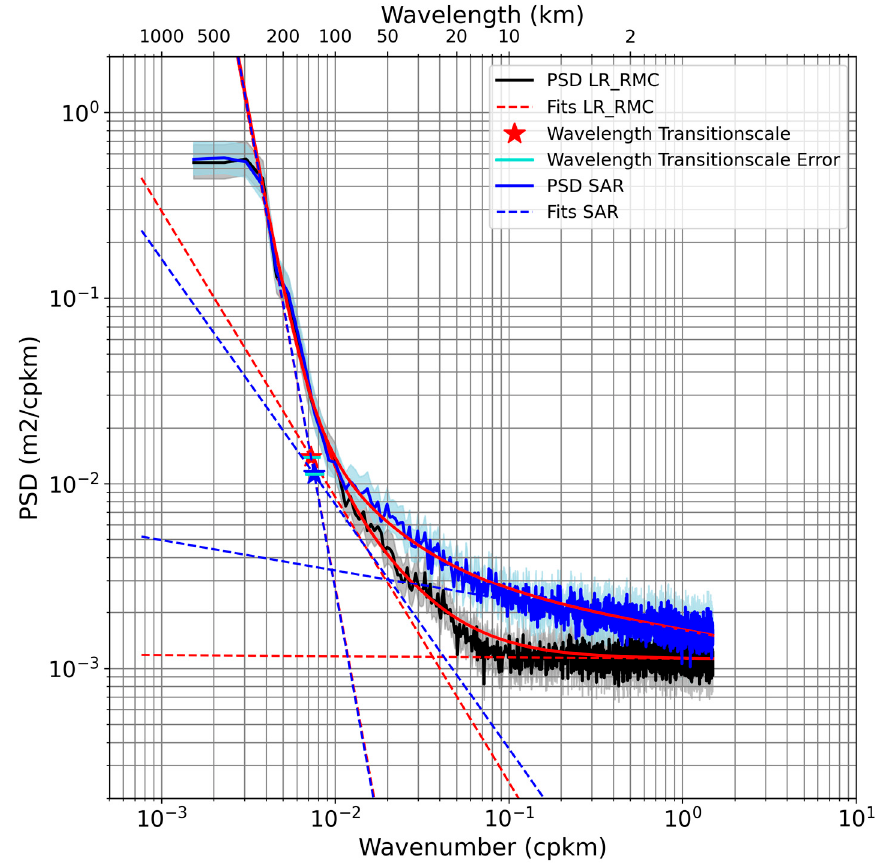
Figure 7. Power spectral density of the SLA along S3A track in the North Atlantic area during the ASO 2017 period. Results obtained with (black) LR-RMC- and (blue) SAR-processed measurements. Reconstructed PSD, as sum of mesoscale, small-mesoscale, and noise components, are displayed with red thick line. Dashed lines show the result of the fit of the 3 components for LR-RMC (dashed red) and SAR (dashed blue).